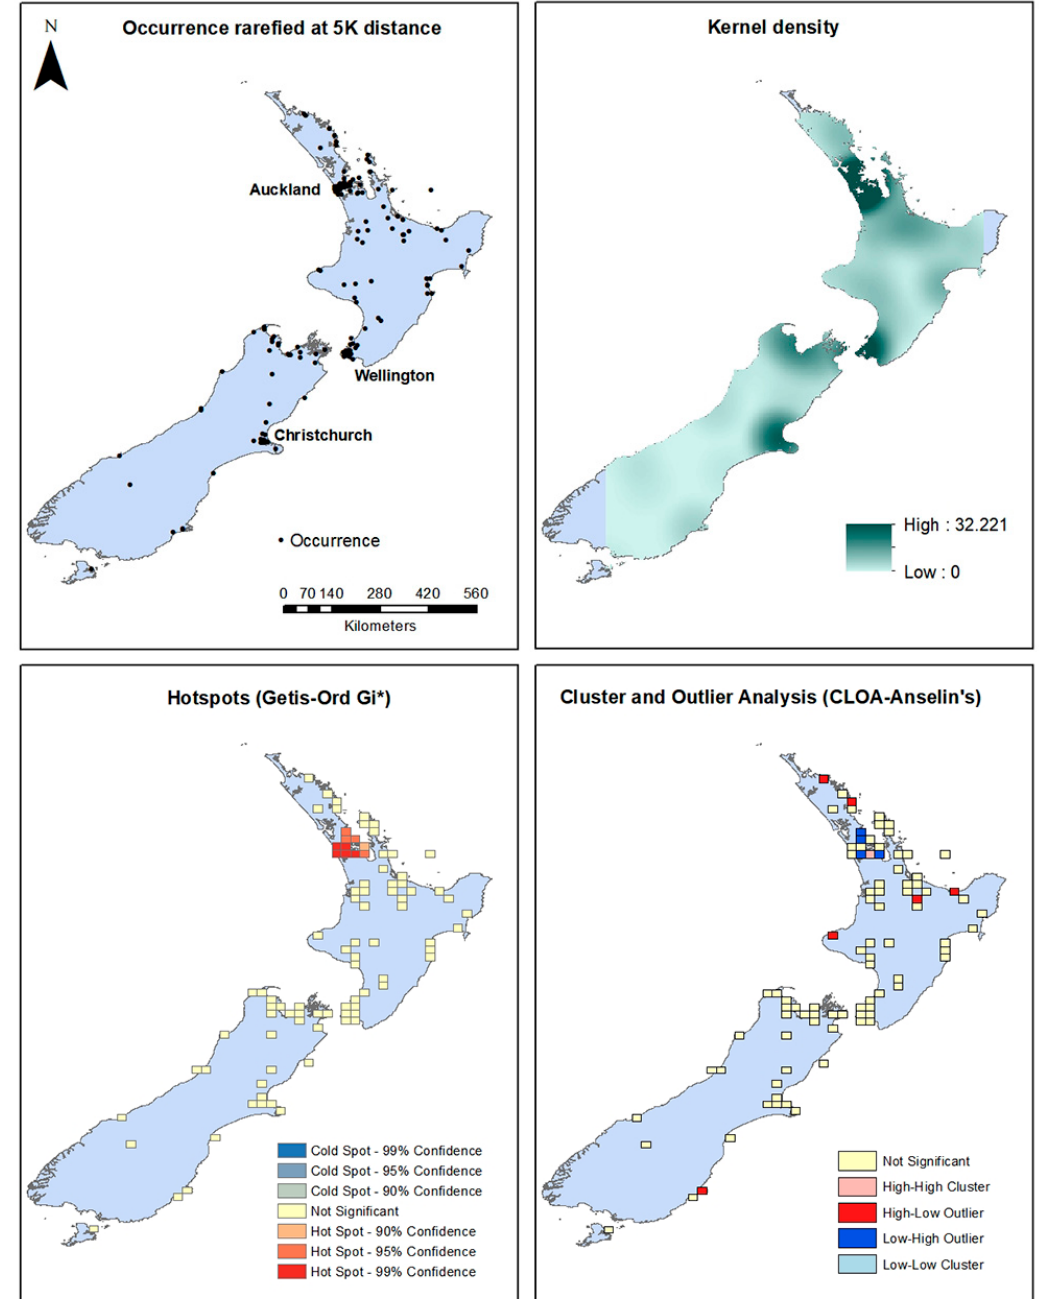
Figure 2. New Zealand occurrences, kernel density surface, Hotspot, and Cluster and Outlier Analysis maps.